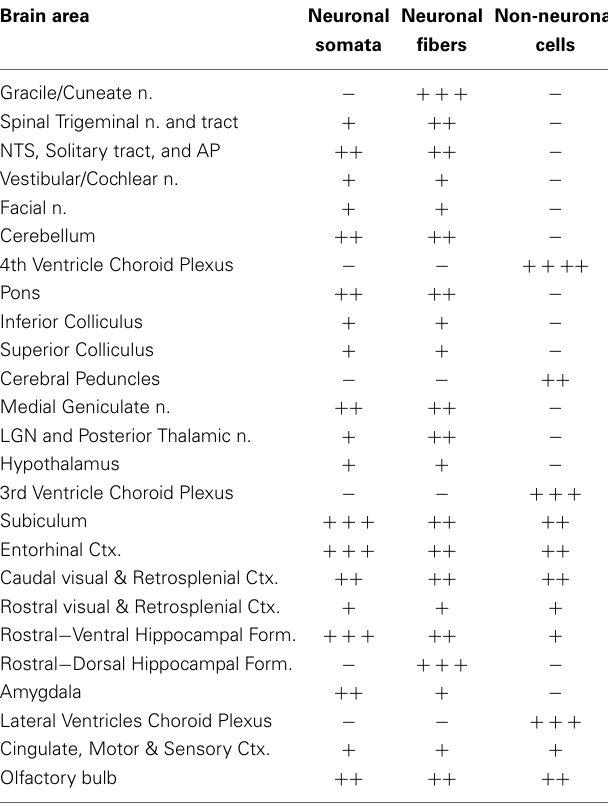
Table 1 | Relative abundance of GFP-ir in brain after intrathecal AAV5-GFP delivery with an intravenous mannitol pretreatment (evaluated in 8 animals from two separate experiments; each structure was observed in at least 3 different sections).